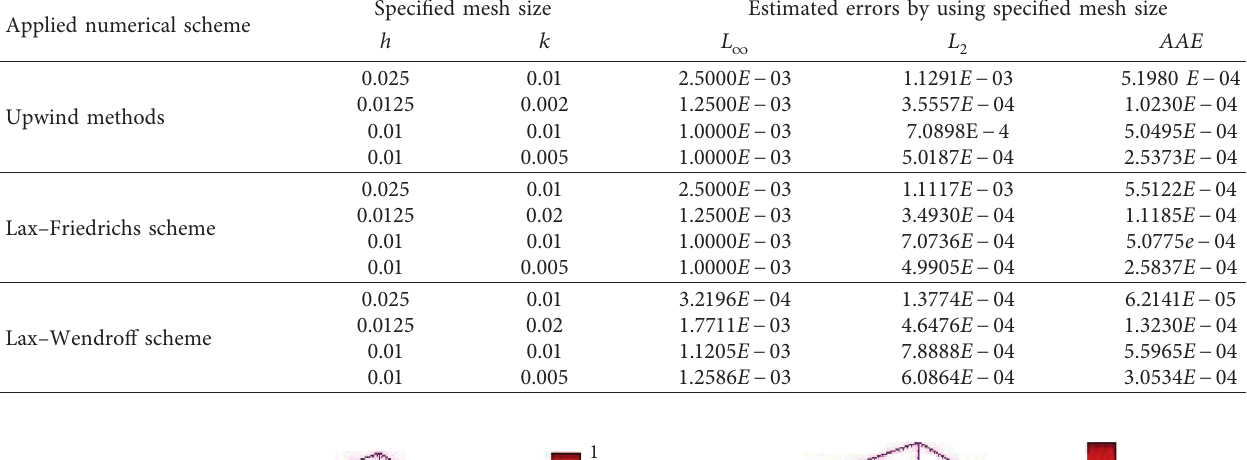
Table 1: Comparison of point average absolute error, root mean square error, and pointwise maximum absolute error for problem give in